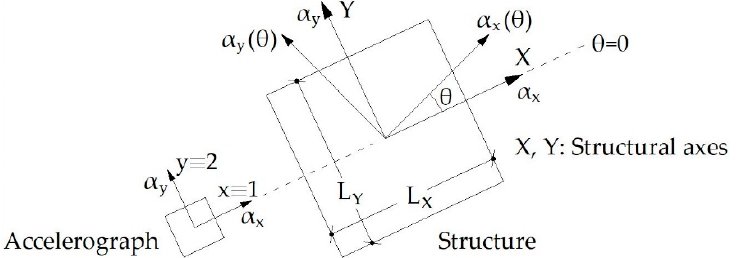
Figure 1. Recorded ground motion and orientation of a building’s structural axes.